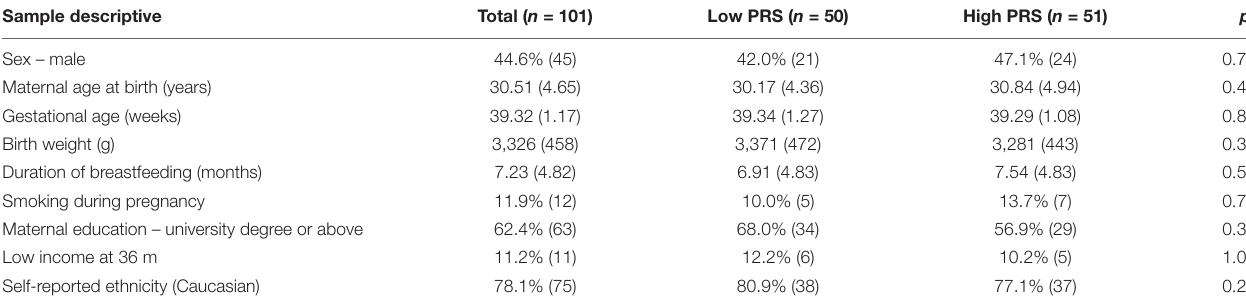
TABLE 3 | Participants’ characteristics in MAVAN.